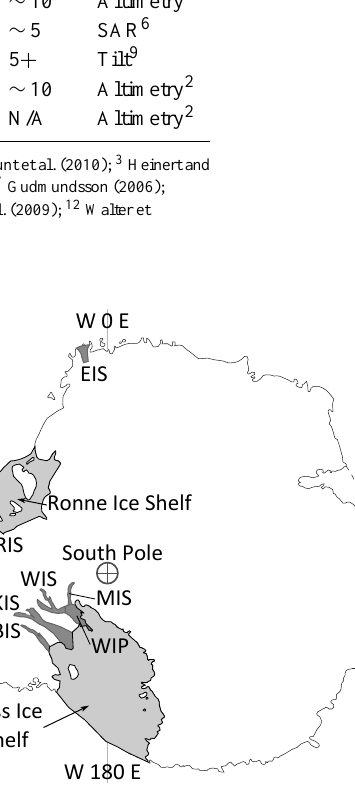
Figure 1. Map of Antarctica indicating locations of the ice streams discussed in this paper (BIS – Bindschadler Ice Stream; EIS – Ekström Ice Stream; KIS – Kamb Ice Stream; PIG – Pine Island Glacier; RIS – Rutford. Ice Stream; WIP – Whillans Ice Plain; WIS – Whillans Ice Stream; MIS – Mercer Ice